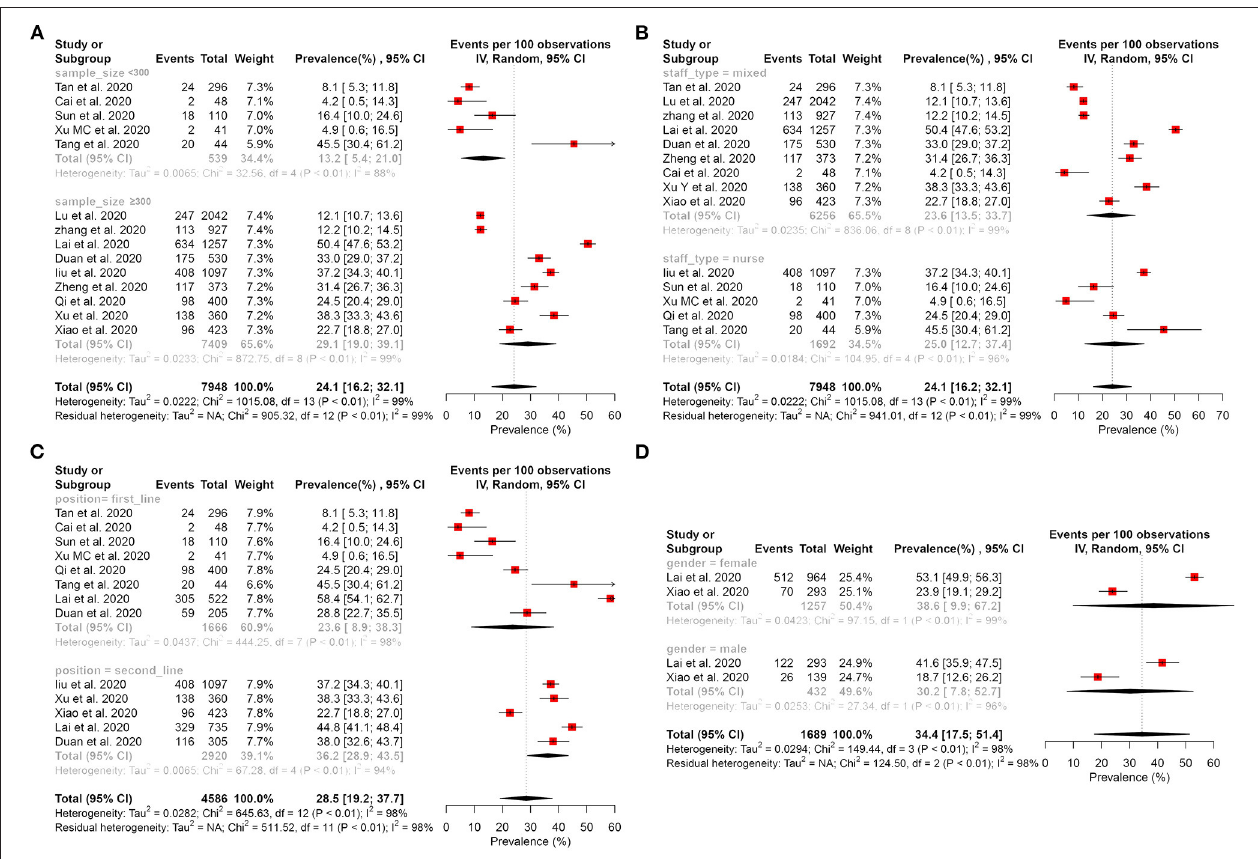
FIGURE 3 | Subgroup analysis of the prevalence of depression among healthcare workers. (A) Subgroup analysis stratification by sample size. (B) Subgroup analysis stratification by staff type. (C) Subgroup analysis stratification by position. (D) Subgroup analysis stratification by